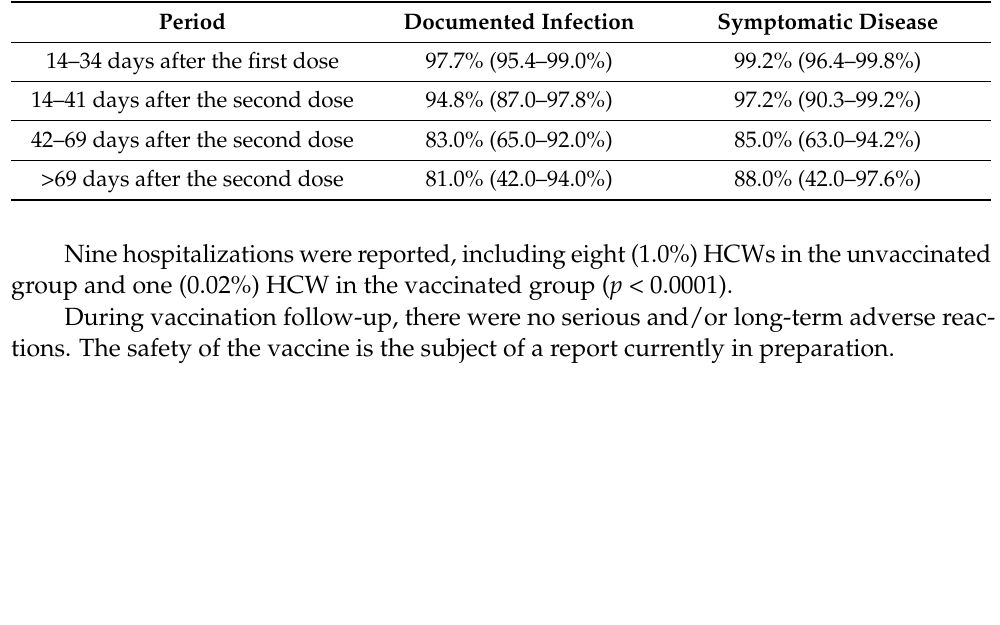
Table 3. Estimated vaccine effectiveness values for documented infection and symptomatic